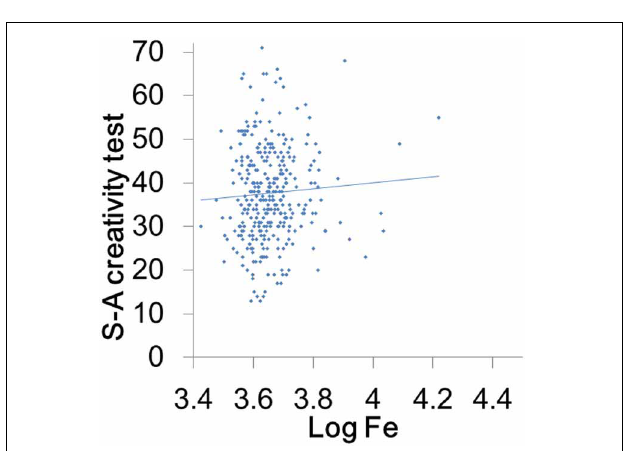
FIGURE 2 | Associations between hair iron levels and creativity. A scatterplot comparing S-A creativity test score and the logarithms of hair iron levels, which shows a nonsignificant association with the trend line.